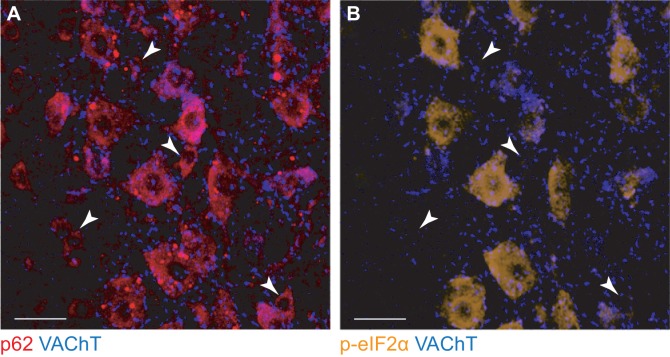
Small motoneurons express low levels of disease markers.(A) Small α-motoneurons (filled arrowheads), identified by the presence of C-boutons (VAChT, blue) do not display p62 aggregates (red). (B) The same small motoneurons (filled arrowheads) express little to no p-eIF2α (orange). Scale bars: 35 µm.